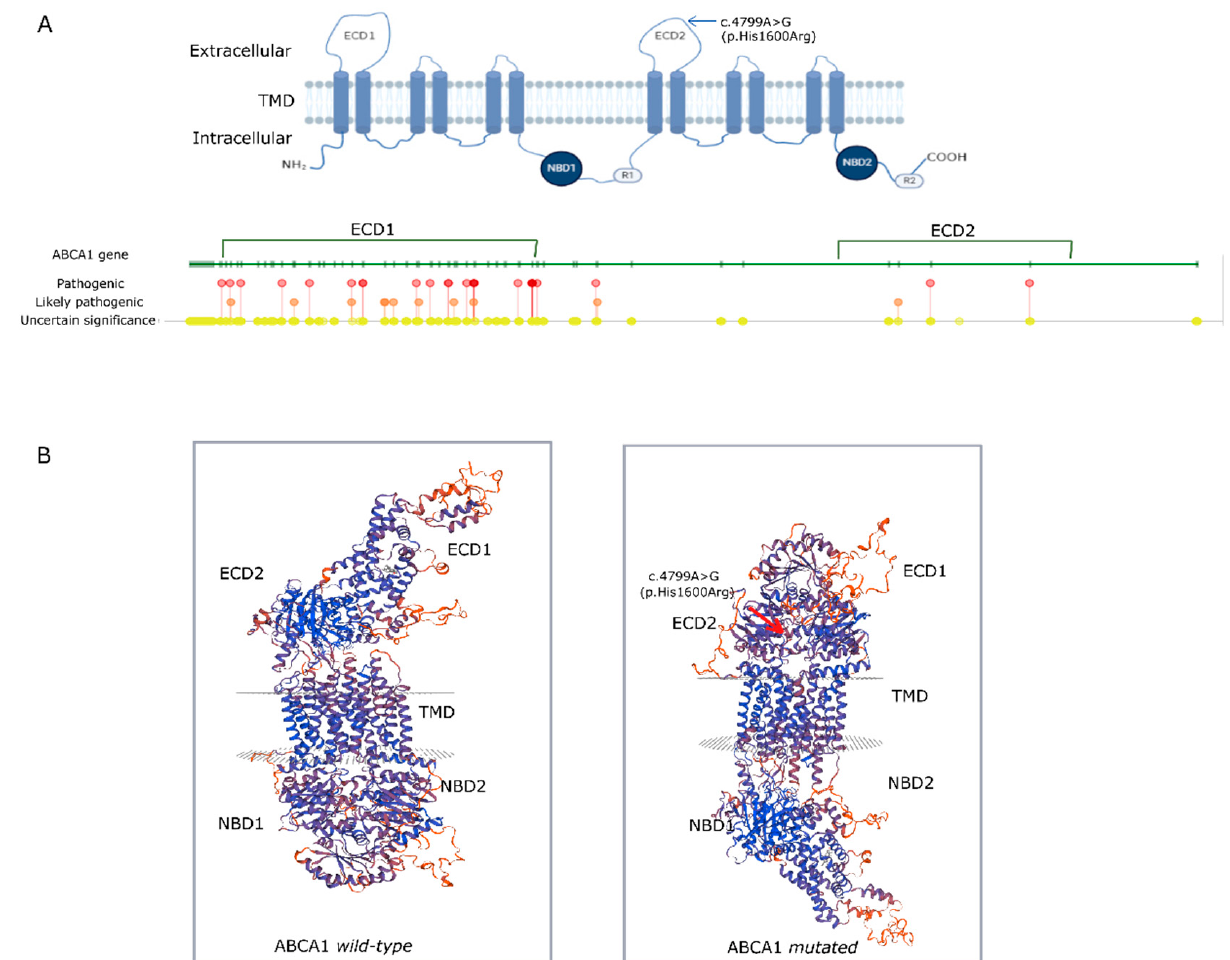
Figure 3. ( A ): Graphical model of the protein domains of ABCA1 along with the ABCA1 gene representation with the variants identified in ClinVar. ( B ): Predicted dimensional model of the wild-type ABCA1 protein without the variant and the ABCA1 variant c.4799A>G (p. His1600Arg), highlighted with a red arrow, reflecting the functional consequences of single-point mutation by substitution of the polar amino acid histidine to the positively charged arginine. ECD—extracellular